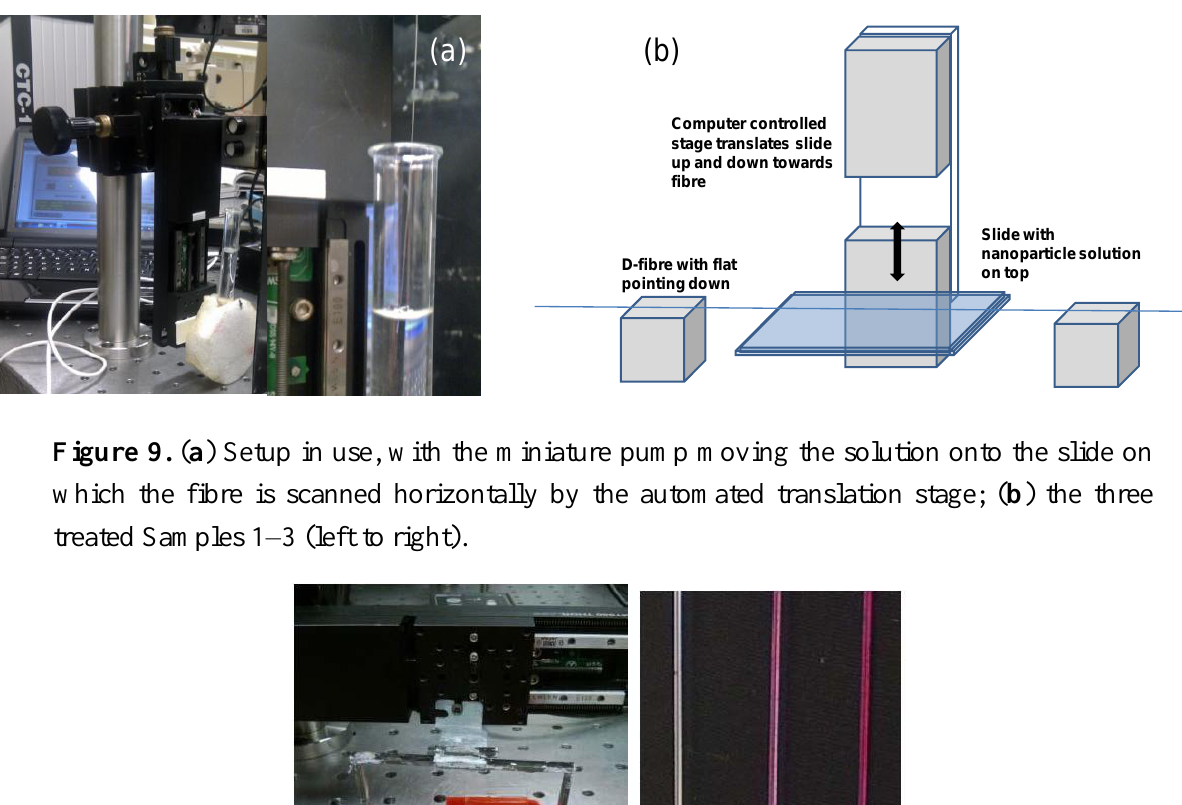
Figure 8. Dip-and-withdraw deposition of nanoparticles: ( a ) vertical; ( b ) horizontal.